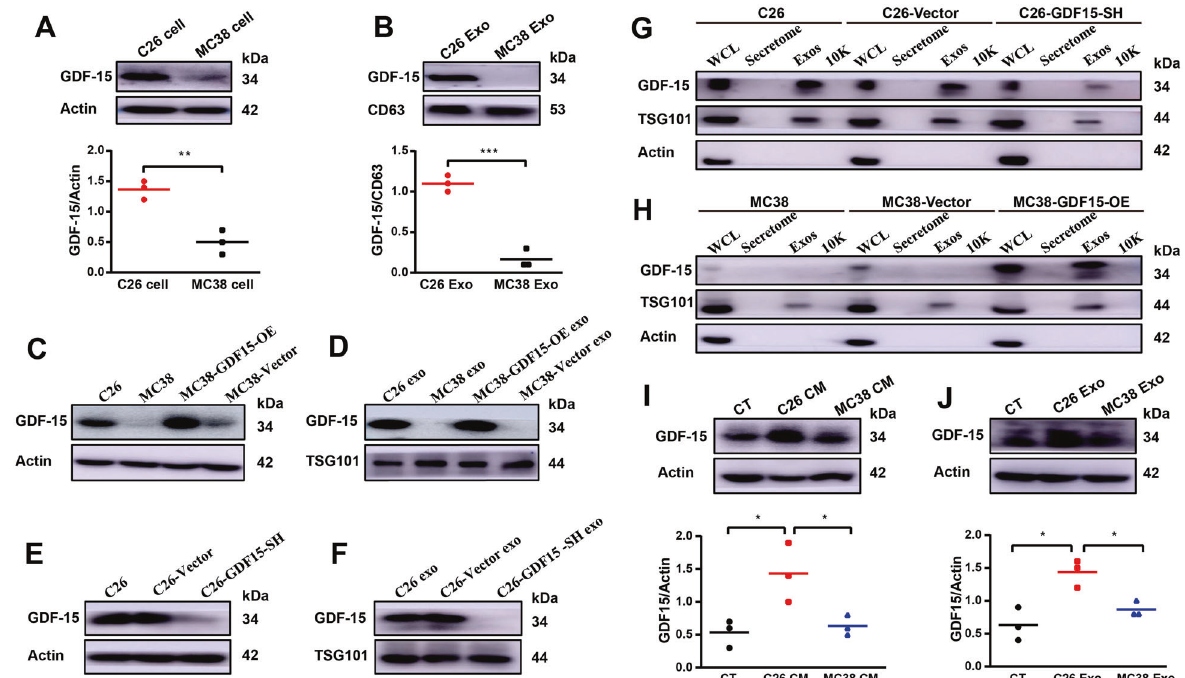
Fig. 2 Con fi rmation of high level of GDF15 in C26 cells, C26 exosomes and secretion of GDF15 via exosomes. The stable cell lines of MC38- GDF15-OE, MC38-Vector, C26-GDF15-SH, C26-Vector were constructed by infected with corresponding lentivirus and then monoclonal cells were picked out for the further study. A Comparison of GDF15 expression levels in MC38 cells and C26 cells ( n = 3, * p < 0.01; t test). B Comparison of GDF15 levels in MC38 exosomes and C26 exosomes ( n = 3, *** p < 0.001; t test). C , D Western blot analysis to con fi rm the up- regulation of GDF15 expression in MC38-GDF15-OE cells C and exosomes D . E , F Western blot analysis to con fi rm the knockdown of GDF15 expression in C26-GDF15-SH cells E and exosomes F . G Western blot analysis of GDF15 level in WCL (whole cell lysates), secretome (soluble secreted proteins), Exos (exosomes) and the cell medium pellet obtained after 10,000 g (10 K) derived from C26 cells, C26-Vector cells and C26- GDF15-SH cells respectively. H Western blot analysis of GDF15 level in WCL, secretome, Exos and 10 K derived from MC38 cells, MC38-Vector cells and MC38-GDF15-SH cells respectively. I Western blot analysis of GDF15 level in C2C12 myotubes treated with C26 tumor cell medium (C26 CM) or MC38 tumor cell medium (MC38 CM) ( n = 3, * p < 0.05; t test). J Western blot analysis of GDF15 level in C2C12 myotubes treated with C26 tumor cell exosomes (C26 Exo) and MC38 tumor cell exosomes (MC38 Exo) ( n = 3, ** p < 0.05; t test). Data presented are the mean ± SEM of three independent